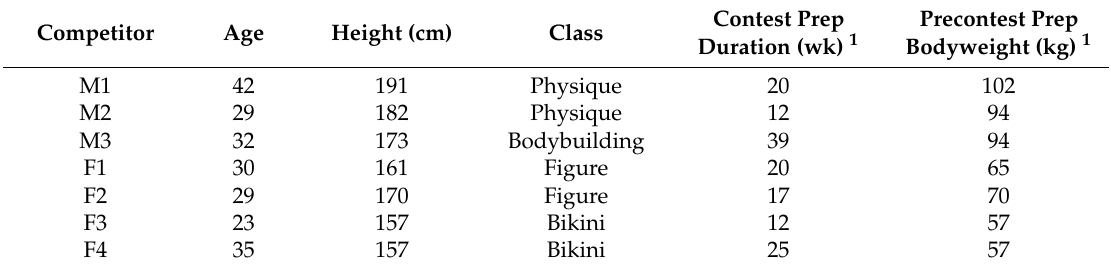
Table 1. Participant descriptive